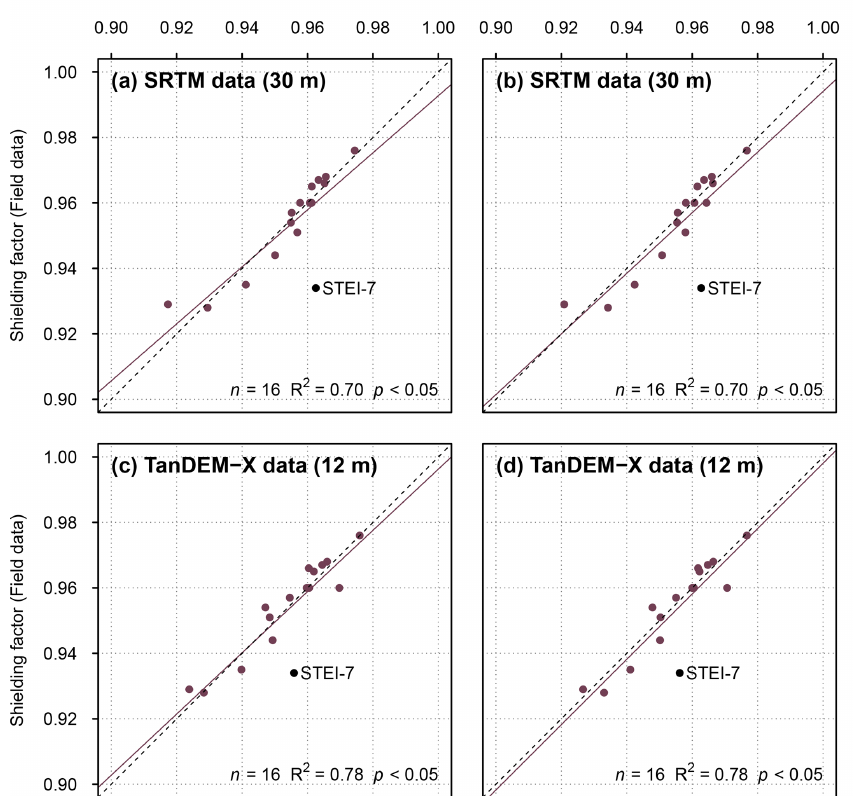
Figure 6. (a) Topographic shielding factors for moraine boulders in the forefield of Steingletscher (Schimmelpfennig et al., 2014) determined with the ArcGIS toolbox and SRTM data versus field-data-based shielding factors. Panel (b) is the same as (a) , but the shielding factors were corrected for the boulder height. (c) Topographic shielding factors computed with the toolbox and TanDEM-X elevation data versus field- data-based shielding factors for the same boulders. Panel (d) is the same as (c) , but the shielding factors were corrected for the boulder